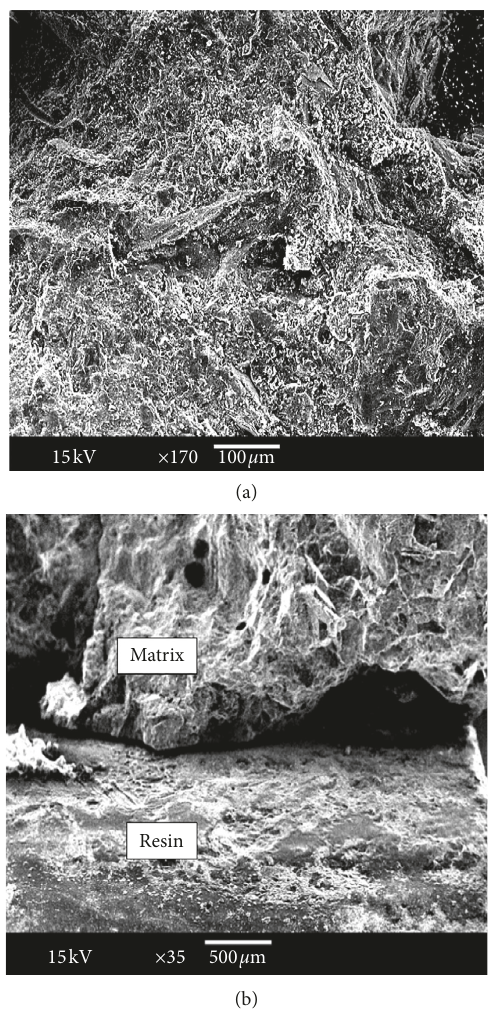
Figure 29: SEM images of RTMC. (a) The self-compacted concrete matrix. (b) Resin/matrix